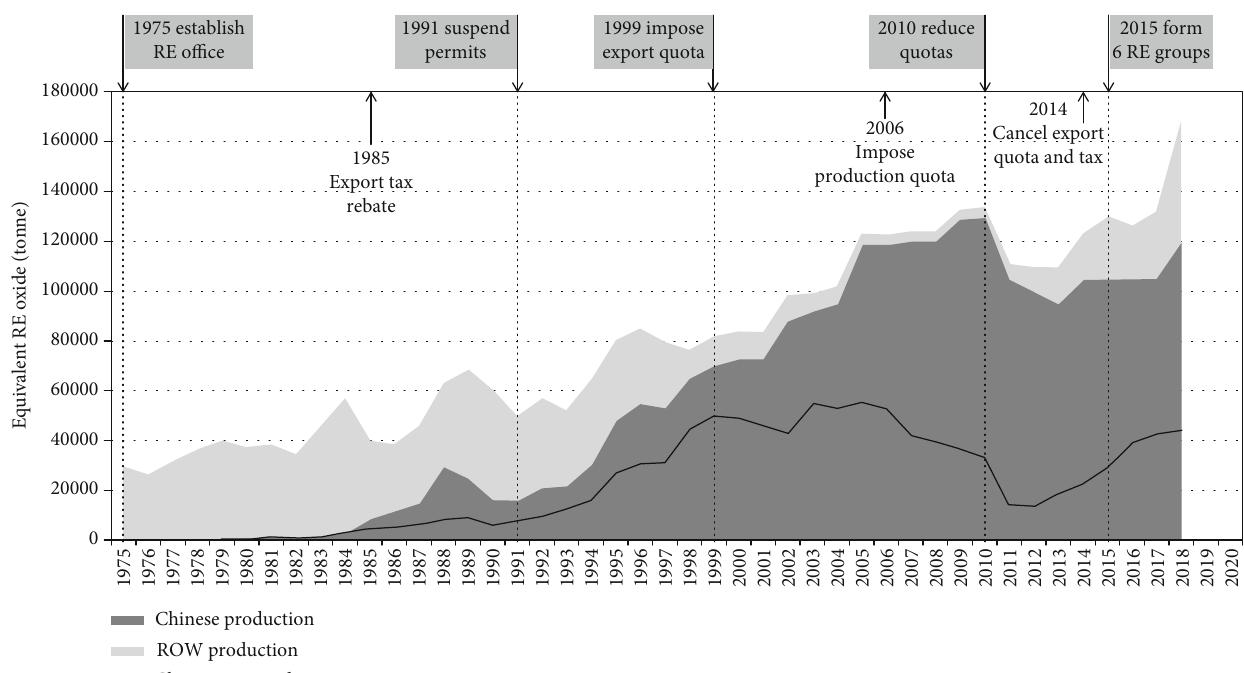
Figure 1: Chinese and rest-of-world mine production of rare earths [6]. This fi gure is reproduced from Shen et al. (2020) (under the Creative Commons Attribution License/public